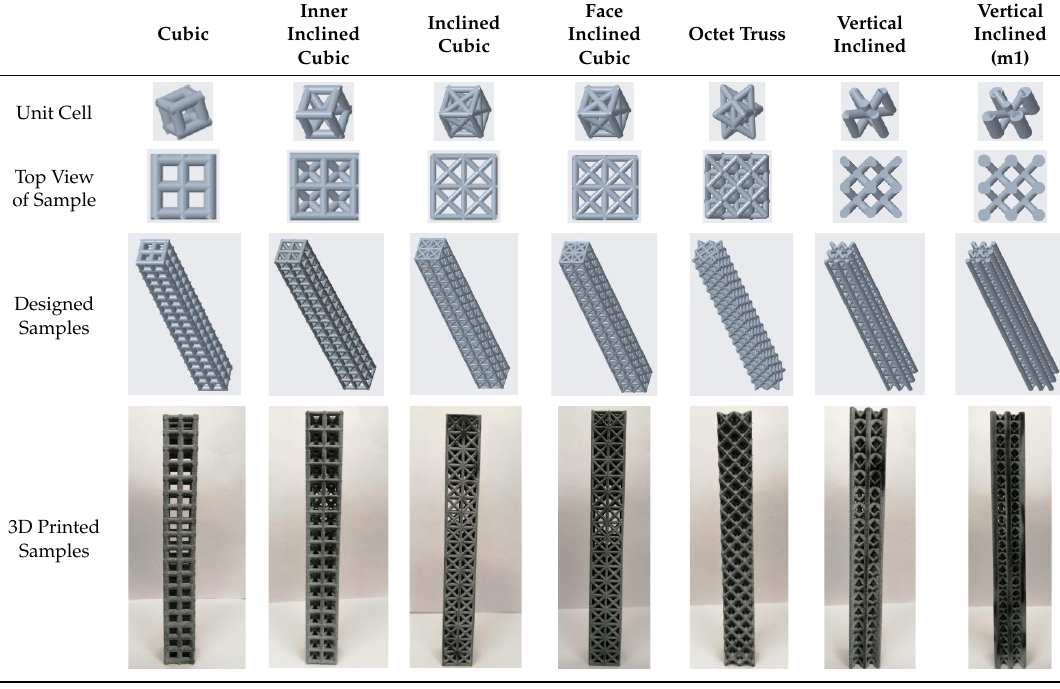
Table 2. Material properties of PA12 polymer.